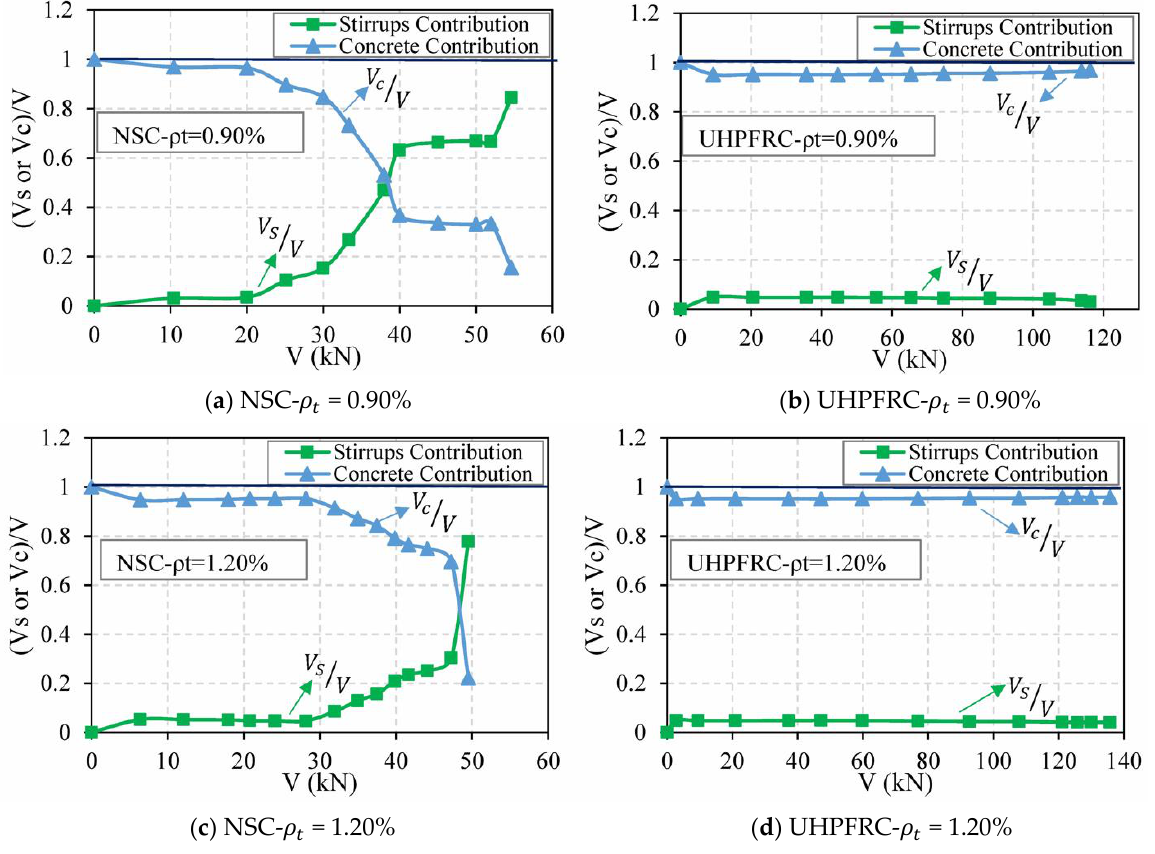
Figure 12. Concrete and stirrups contribution to shear capacity of NSC and UHPFRC beams with different reinforcement ratios ( 𝜌 𝑡 = 0.90% and 𝜌 𝑡 = 1.20%).